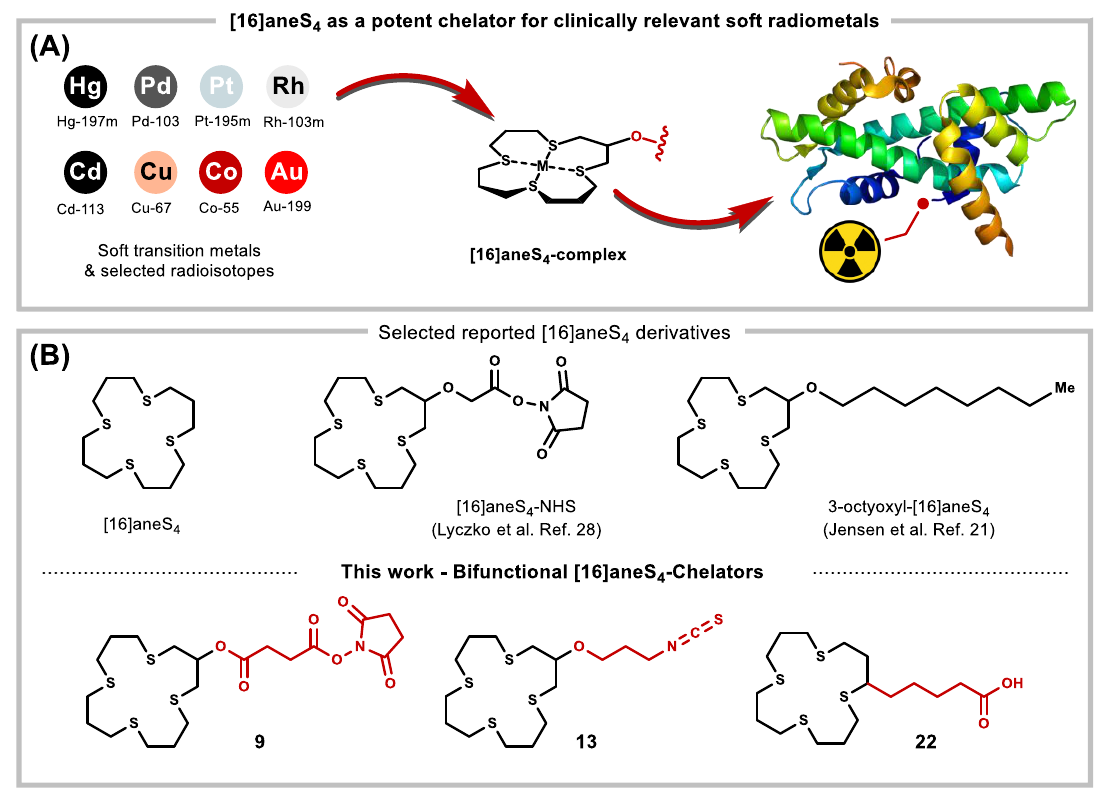
Figure 1. ( A ) Bifunctional [16]aneS 4 chelators as a general strategy for soft radiometal complexes for bio-conjugation, with application in targeted radiotherapy and radiodiagnostics. ( B ) Examples of reported [16]aneS 4 chelator derivatives and the novel [16]aneS 4 bifunctional chelators reported in this manuscript.